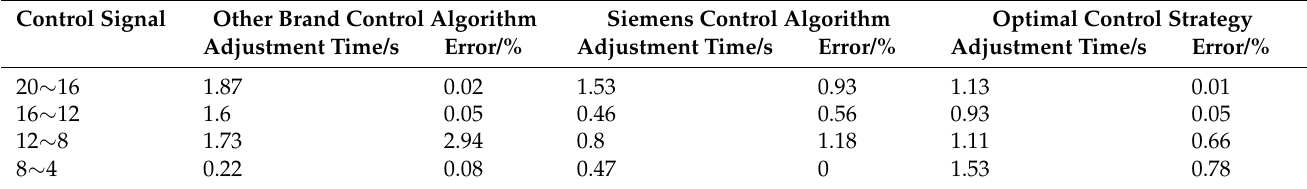
Table 4. Comparison of large-range exhaust control algorithms.